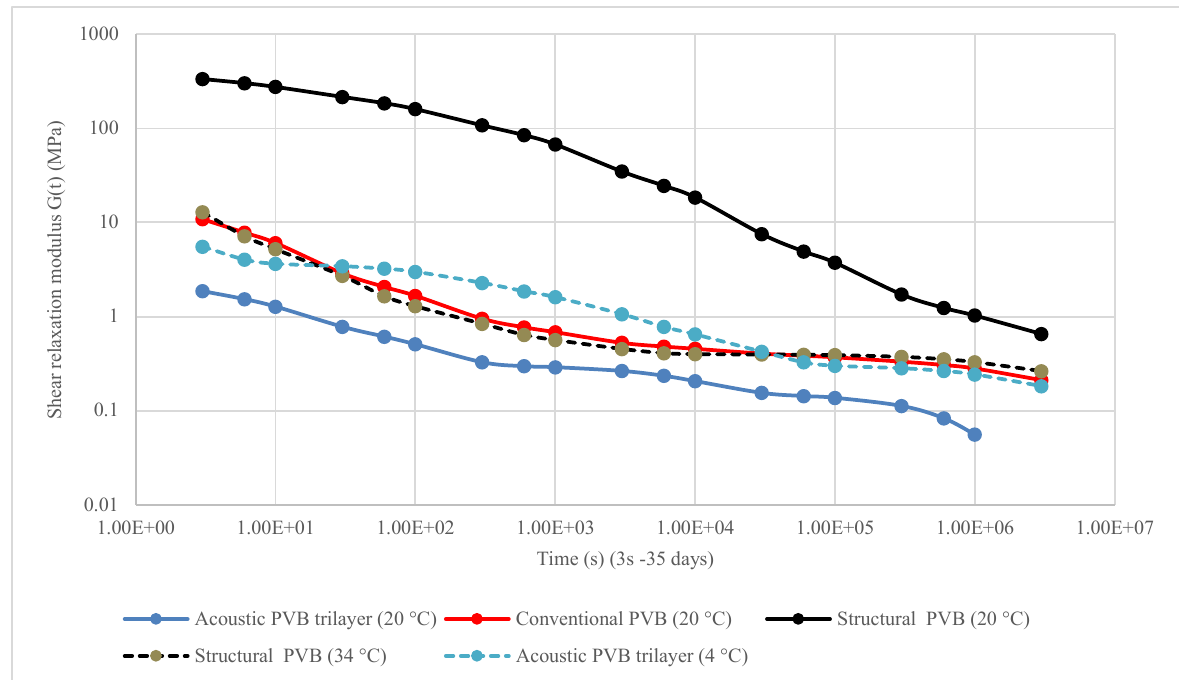
Fig. 9 Shear relaxation modulus for main PVB types for durations between 3s and 35 days based on the models of Tables 1-3 at 20 °C (dotted lines “closest match curves” to conventional PVB at 20 °C – see